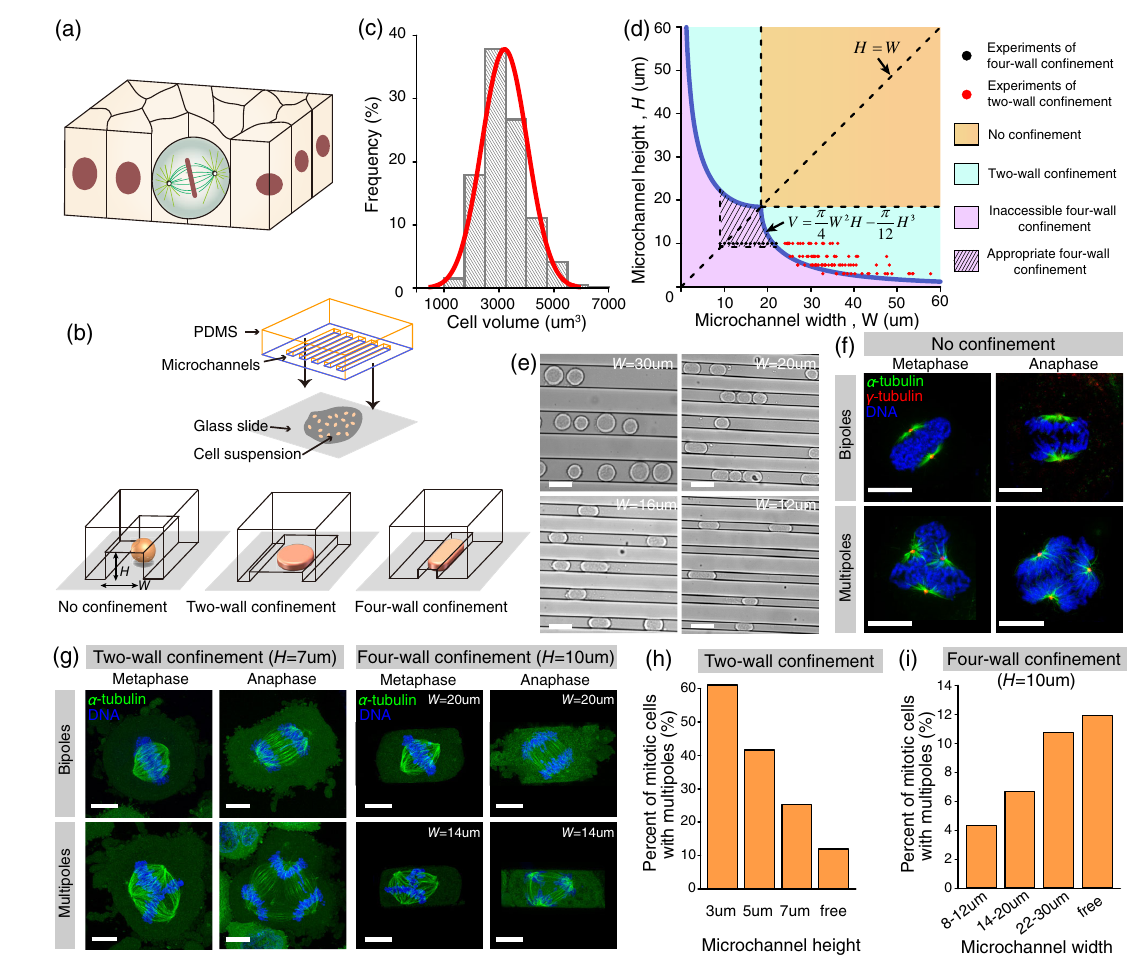
FIG. 1. Frequent multipolar mitosis under two-wall confinement and rare multipolar mitosis under four-wall confinement. (a) Schematic diagram of the mechanical confinement from epithelial tissue architecture during mitosis. (b) Schematic diagram of mitotic cells under no confinement, two-wall confinement, and four-wall confinement. (c) Distribution of cell volume of HeLa cells. (d) Phase diagram of the level of mechanical confinement to mitotic cells. (e) Bright field images of cells in microchannels with H ¼ 10 μ m and various widths. The scale bar is 30 μ m. (f,g) Images of metaphase and anaphase HeLa cells under no confinement (fixed cells), 7 μ m height confinement (living cells), and four-wall confinement (living cells) with stained α tubulin (green), γ tubulin (red), and DNA (blue). The scale bar is 10 μ m. (h,i) Percentage of multipolar mitosis in all mitotic cells in free culture ( n ¼ 1210 ), two-wall ( n ¼ 756 , 1060, 719), and four-wall confinement ( n ¼ 372 , 556,